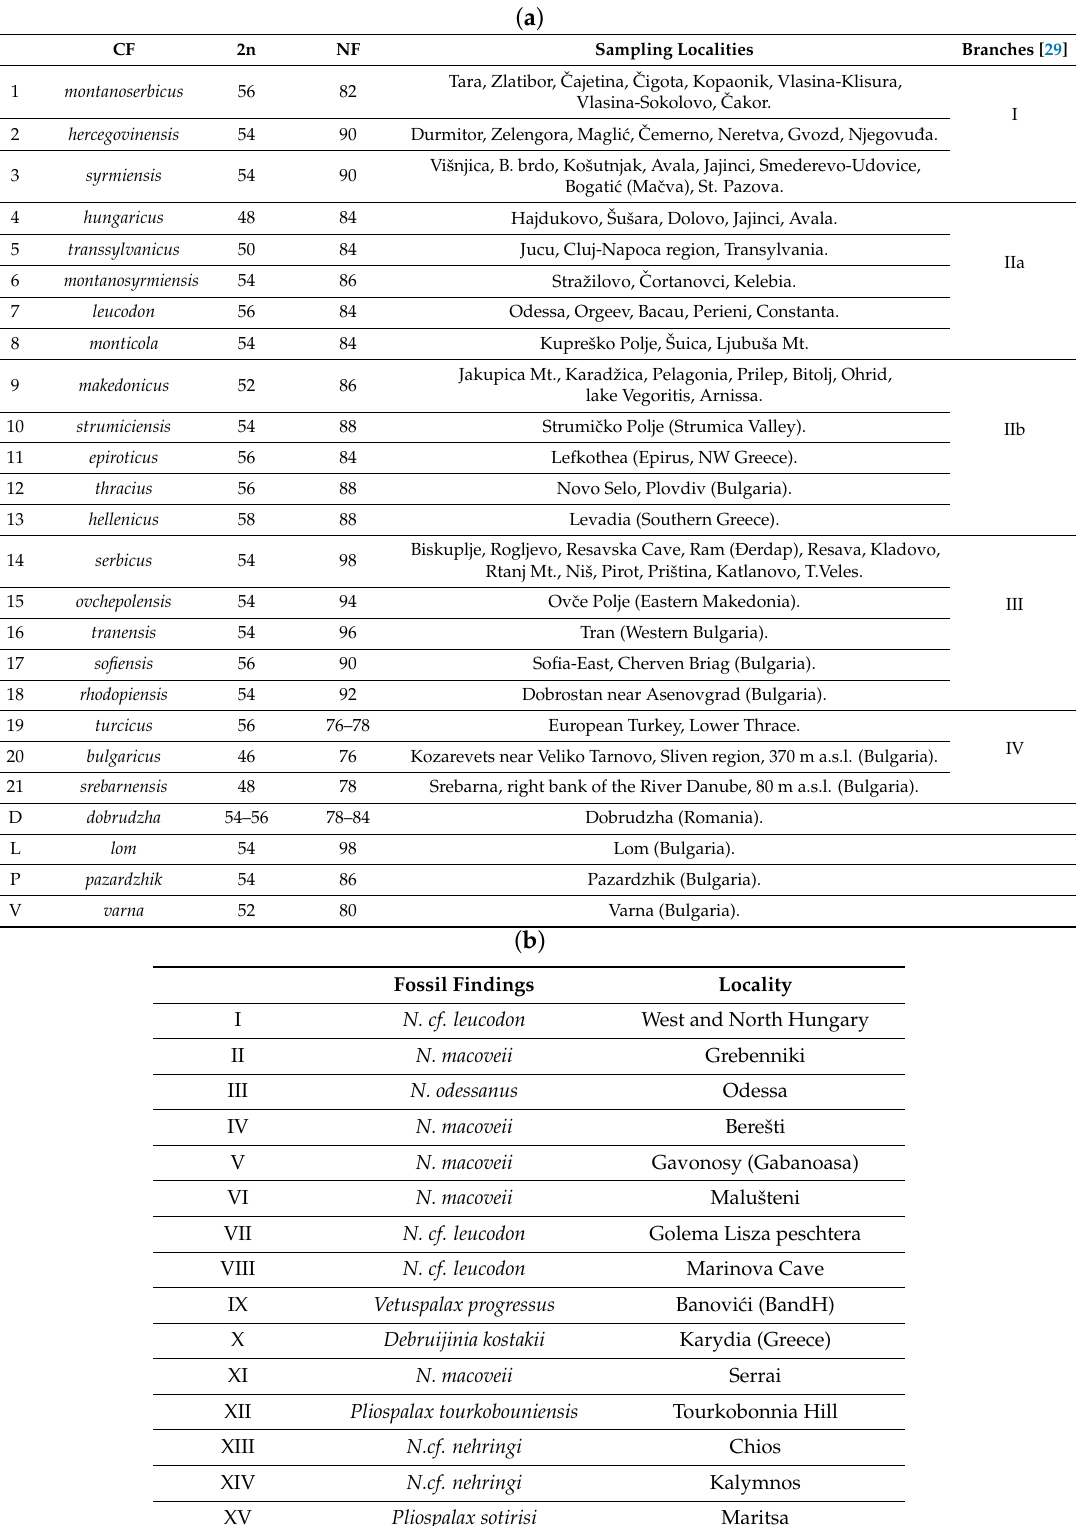
Table 1. Chromosomal forms (CFs) and localities of recent and extinct Nannospalax leucodon from South-eastern Europe, as presented in Figure 1: ( a ) CFs grouped in four branches, following [29]; ( b ) fossil findings with